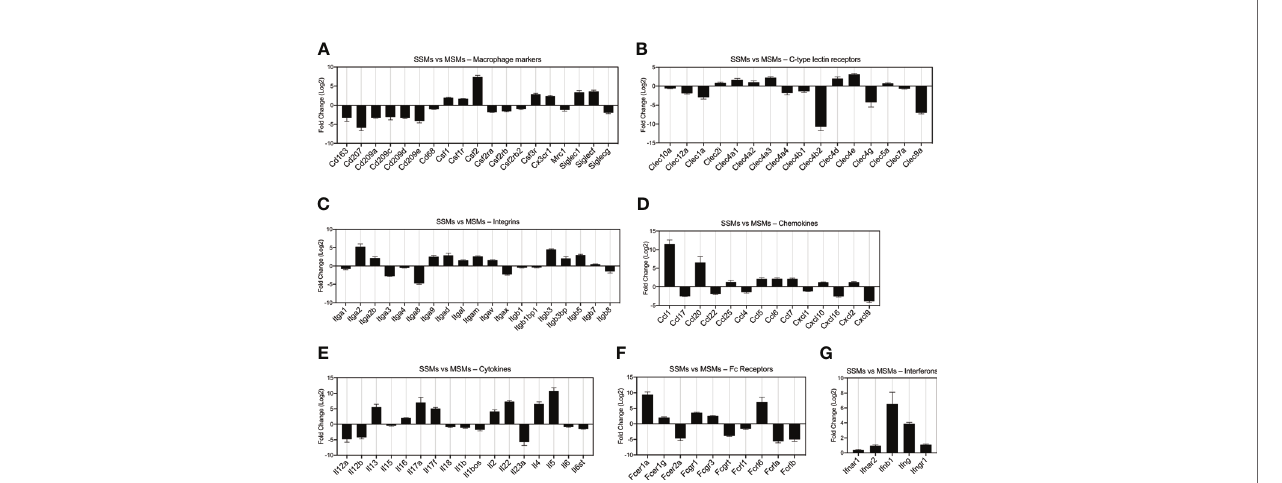
FIGURE 2 | Comparison of gene expression between SSMs and MSMs isolated from non-draining lymph nodes. Gene families of interest are shown. Genes shown have a p-adjusted value < 0.01 and a mean expression level > 100 reads. (A) Macrophage markers. (B) C-type lectin receptors. (C) Integrins. (D) Chemokines. (E) Cytokines. (F) Fc receptors. (G) Interferons and receptors. Fold change > 0 indicates genes upregulated in SSMs. Fold change < 0 indicates genes upregulated in